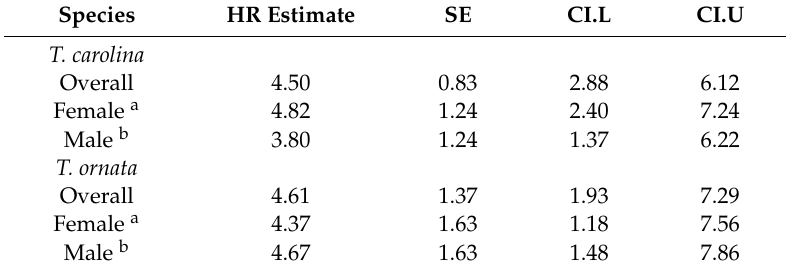
Table 1. Raw mean home range (HR) estimates with standard error (SE) and 95% confidence intervals (CI.L ( = lower limit of confidence interval) and CI.U ( = upper limit of confidence interval)) for T. carolina and T. ornata by species and sex, using only studies where turtle sex was identified. Superscript letters show within-species di ff erences between females and males, based on Holm–Bonferroni pairwise post hoc comparisons.